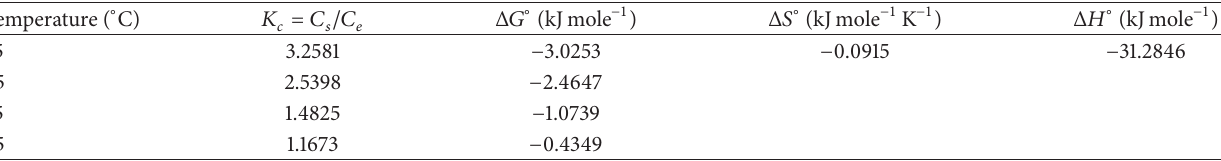
Table 5: Thermodynamic parameters for the adsorption of AB25 on IJSP Conditions as in Table 4.